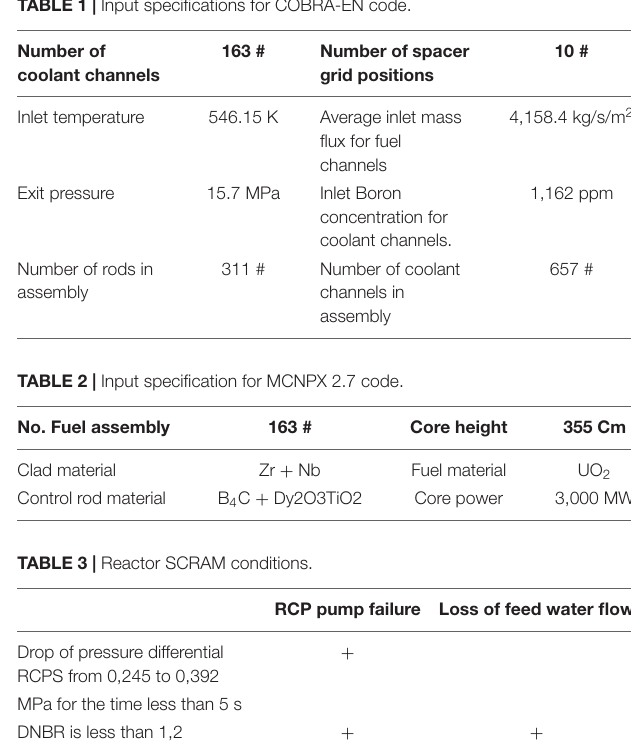
TABLE 4 | ATWS scenarios.